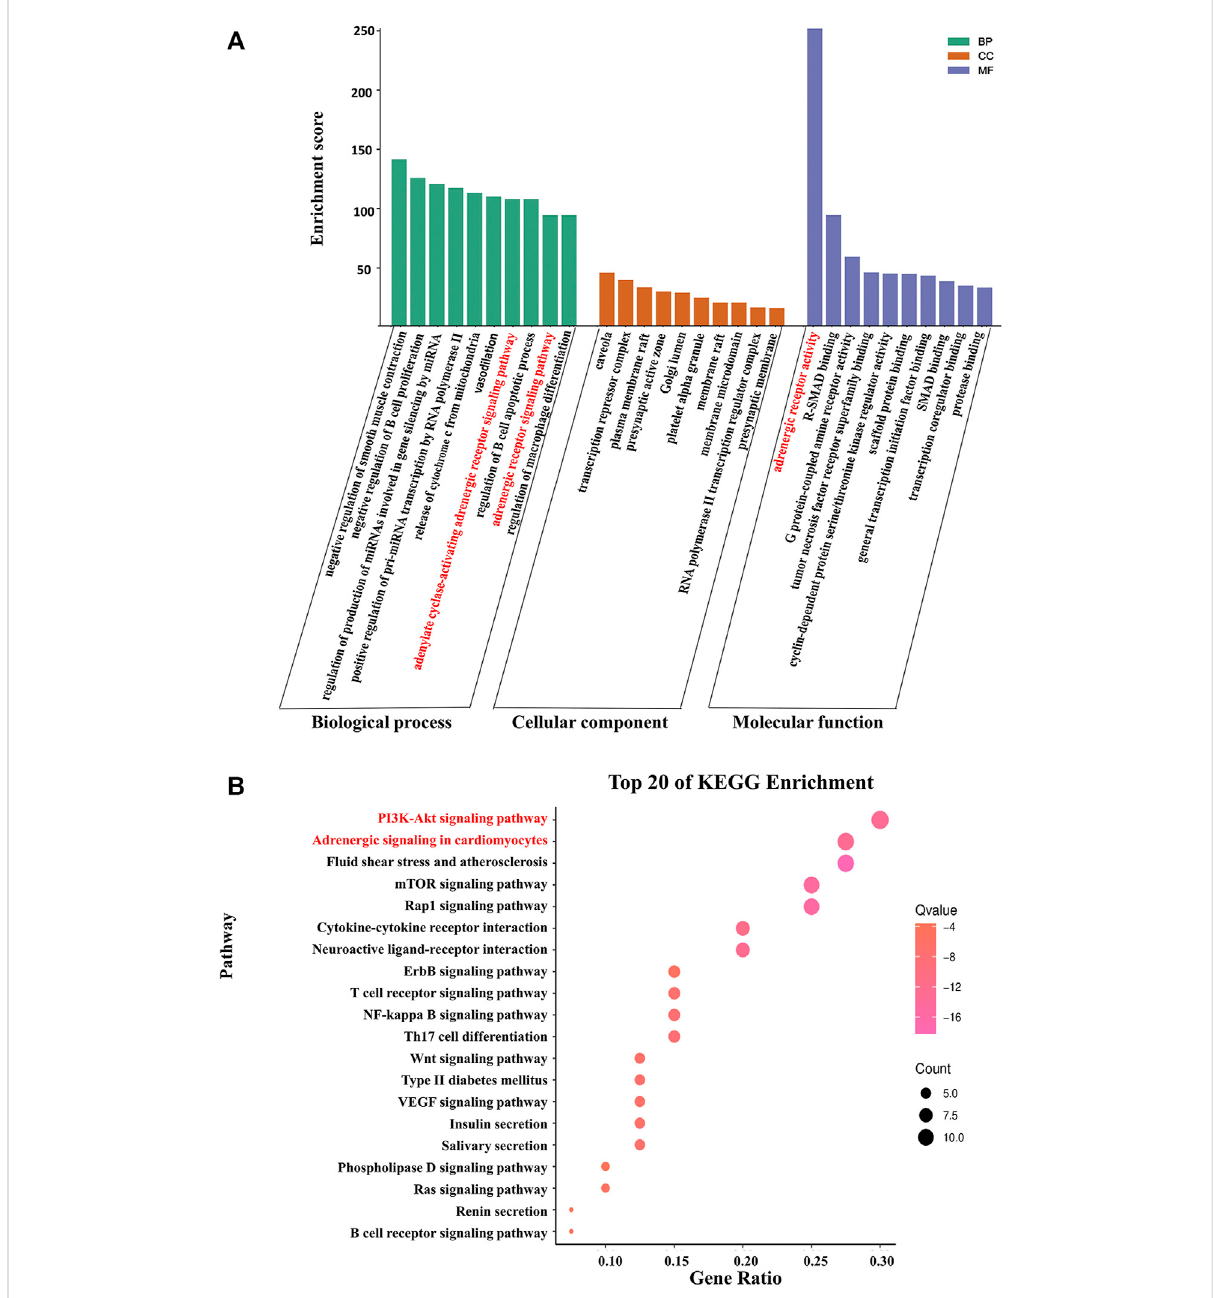
FIGURE 4 KEGG pathway enrichment analysis and GO functional enrichment analysis of Cordyceps in treating bradyarrhythmia. (A) GO functional analysis.Thetop10itemsofeachpartareshown. (B) KEGGpathwayenrichmentanalysis.Thesizesofthebubblesareillustratedfromlargetosmallin descending order of the number of potential targets involved in the